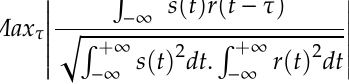
( b ) Figure 10. Input/output signal pulses for ( a ) side by side and ( b ) face to face scenarios. A relatively good similarity has been achieved for the R X and T X pulses, as shown in Figure 10. In addition, using (1) the fidelity factor of the reference antenna pair are calculated and good results have been obtained (equal to 0.85 and 0.75, respectively). A prototype sample of the proposed UWB dual ‐ polarized antenna is fabricated and tested. Figure 11 shows the placements of the fabricated